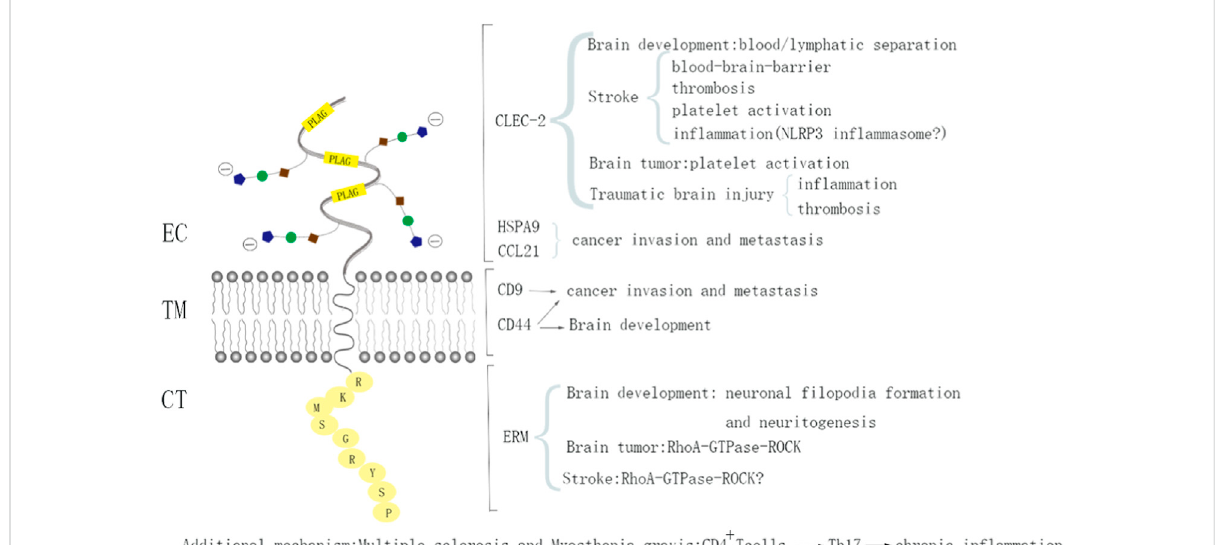
FIGURE 1 The structure of podoplanin and its functions with interacting proteins. Schematic representation of the molecular structure of podoplanin showing that it has a heavily glycosylated extracellular domain, a single transmembrane domain, and a short 9-amino acid cytoplasm. The ligands and biological processes during which the identi fi ed molecules interacting with podoplanin are presented. EC, ectodomain; TM, transmembrane region; CT, cytosolic